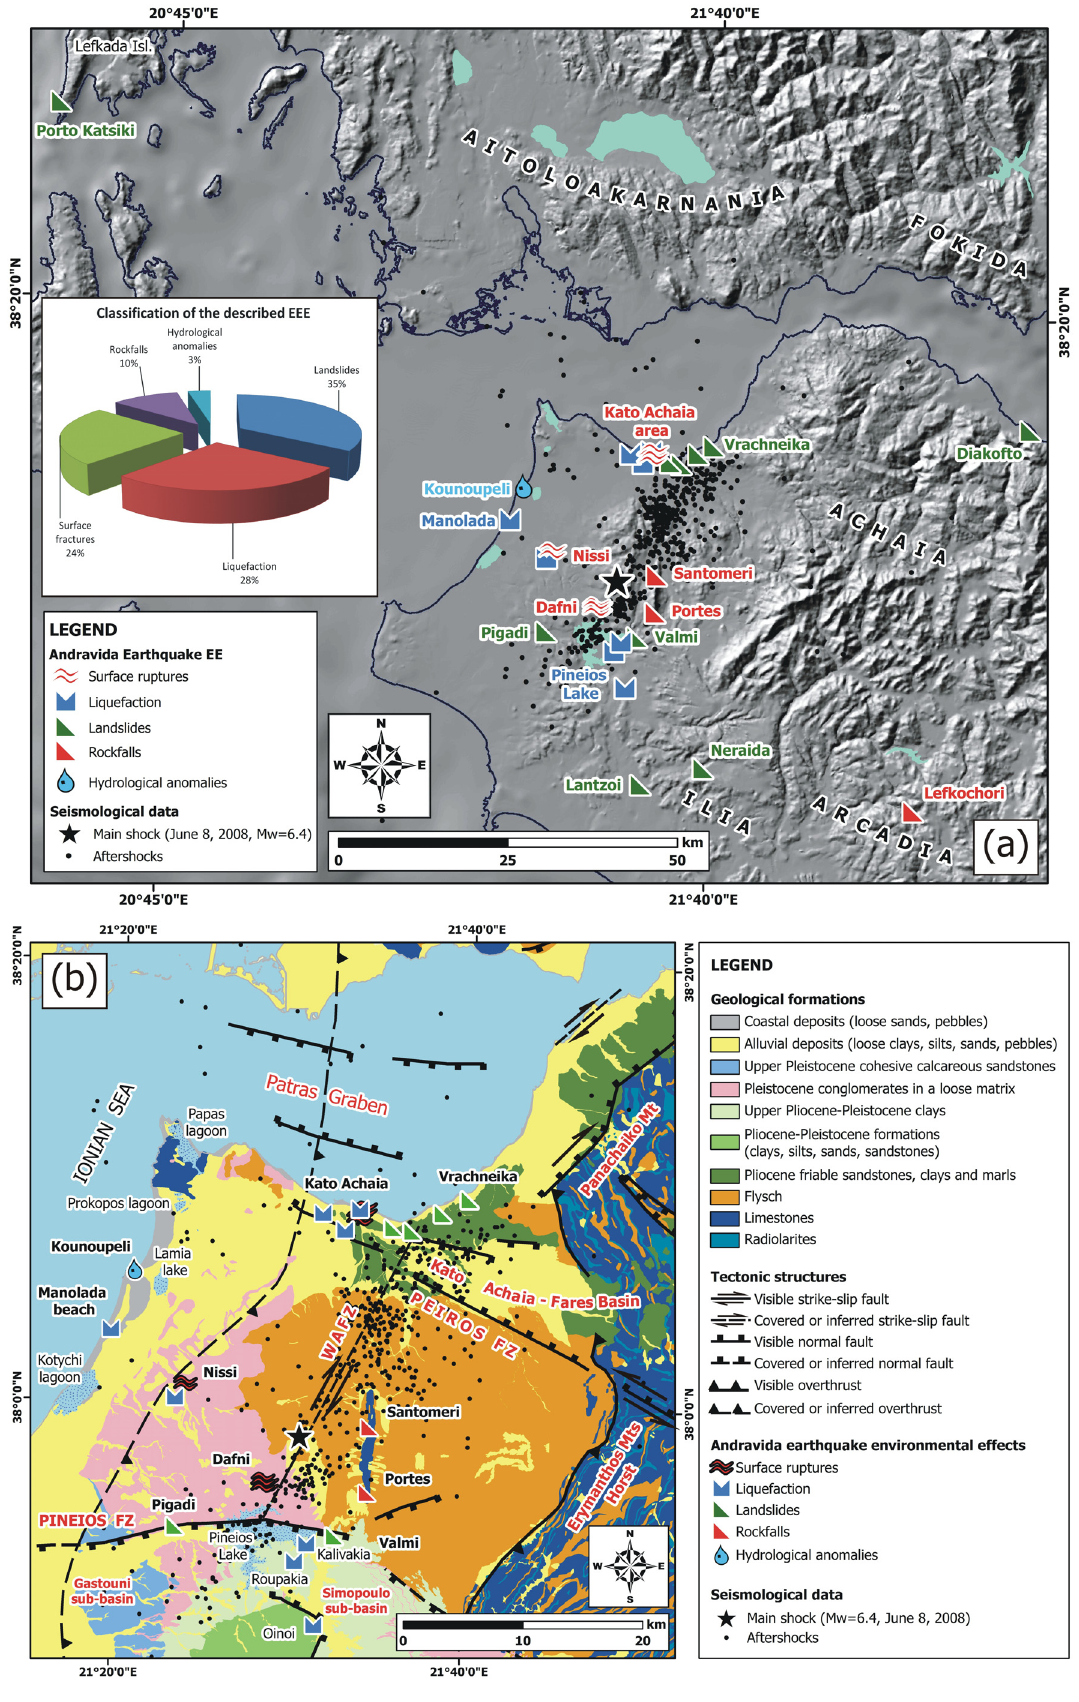
Figure 2. The spatial distribution of the 2008 Andravida EEE in (a) the NW Peloponnese wide area and (b) in the epicentral area of the 2008 Andravida earthquake according to the Table 1. The percentage distribution of the Andravida EEE by type is also presented. The epicenter distribution for the Andravida aftershock sequence is from the aftershocks catalogue presented by the Department of Seismotectonics, Earth- quake Planning and Protection Organization (from June 8 to June 20, 2008) [Lalechos et al.